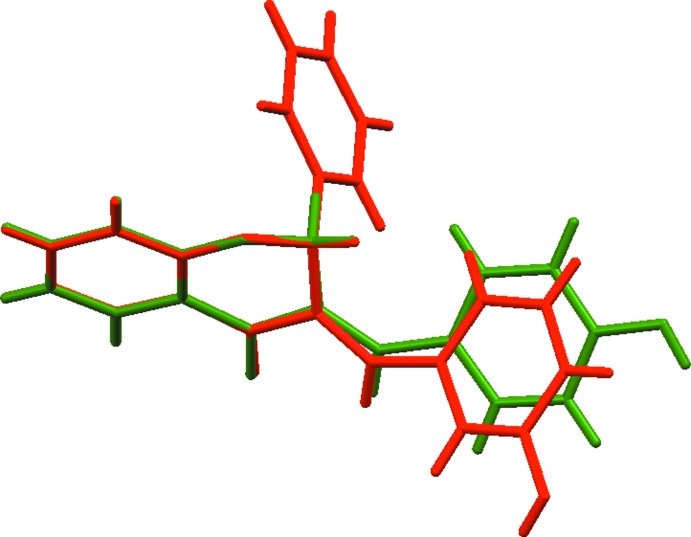
Overlay of compound I (green) and compound II (red).